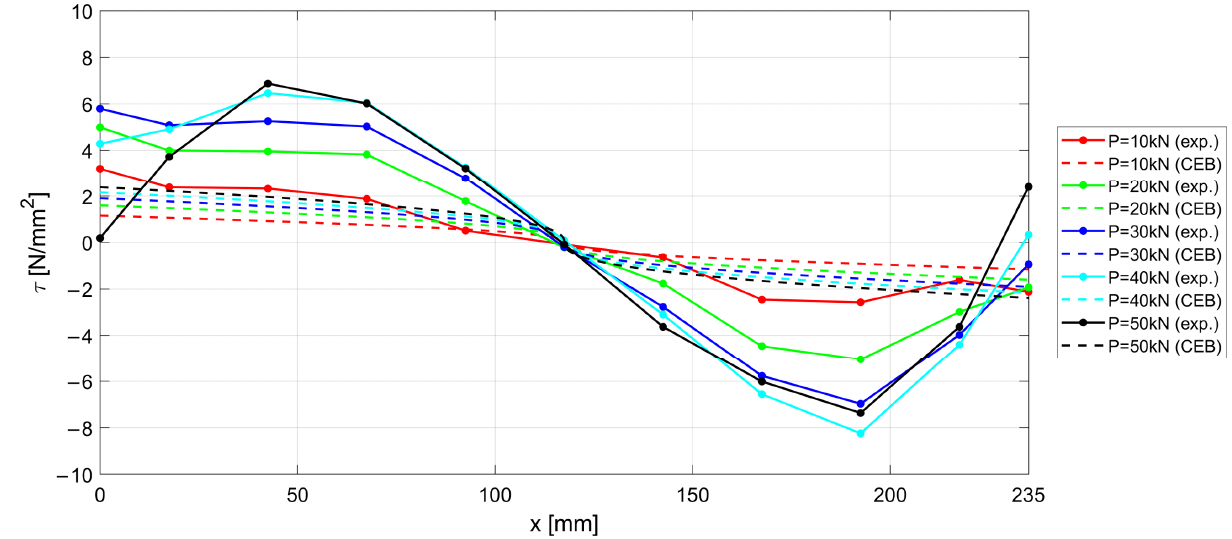
Figure 19. Experimental and numerical τ − x curves for increasing load P